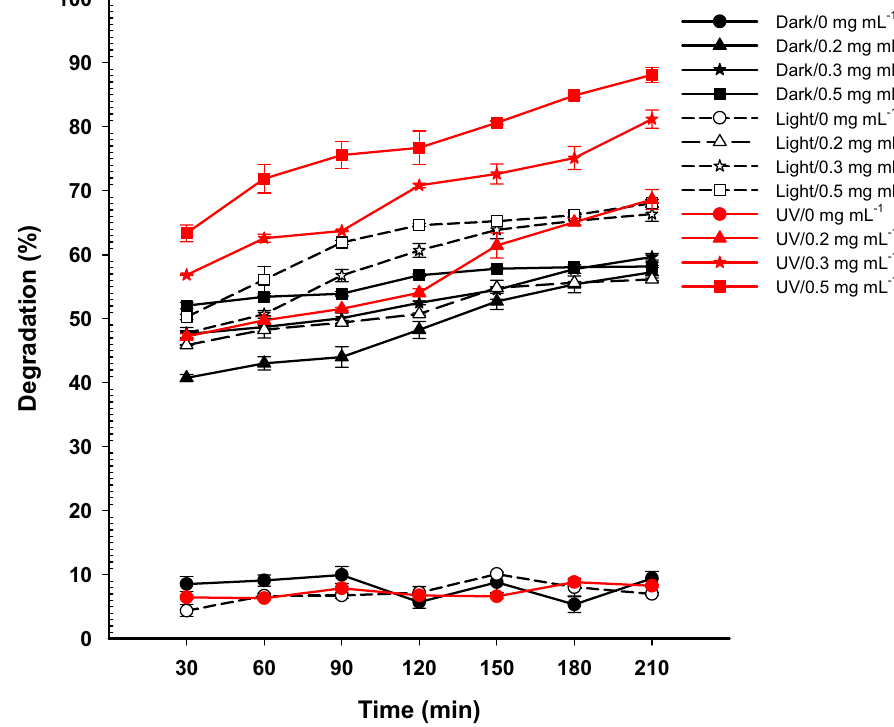
Figure 7. The catalytic activity of different concentrations of Se-NPs (0.2 mg, 0.3 mg, and 0.5 mg/mL MB aqueous solution) for the degradation of methylene blue dye under dark, visible light, and UV-irradiation